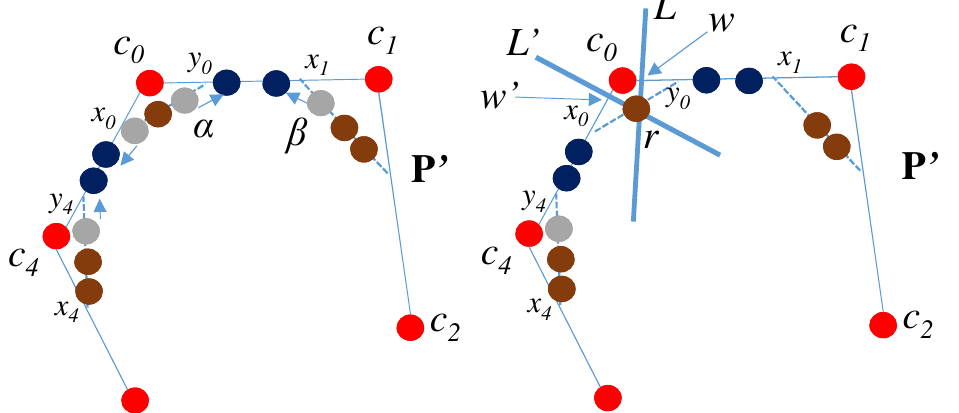
Figure 13. An illustration of how robots on EL i move to the sides of P (cid:48) in Stage 1.4 Suppose α sees both c i and c i + 1 (the case of β seeing c i , c i + 1 is analogous). Robot α assumes color transit_moving and moves to the point ρ at distance length ( c i c i + 1 ) /4 from c i in c i c i + 1 . Then, α changes its color to side2 . Repeat this process so that one more robot α (cid:48) places itself at point (cid:36) at distance length ( c i c i + 1 ) /4 from c i + 1 in c i c i + 1 . This robot α (cid:48) will be γ